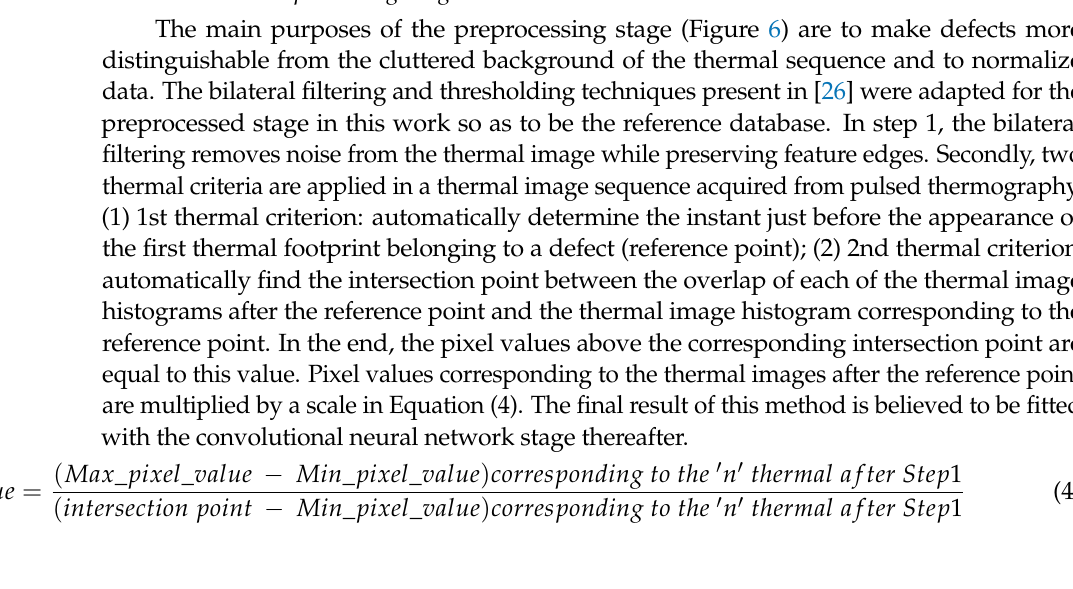
Figure 5. Proposed workflow to train with a deep learning model based on the data generation by Finite Element Modeling.